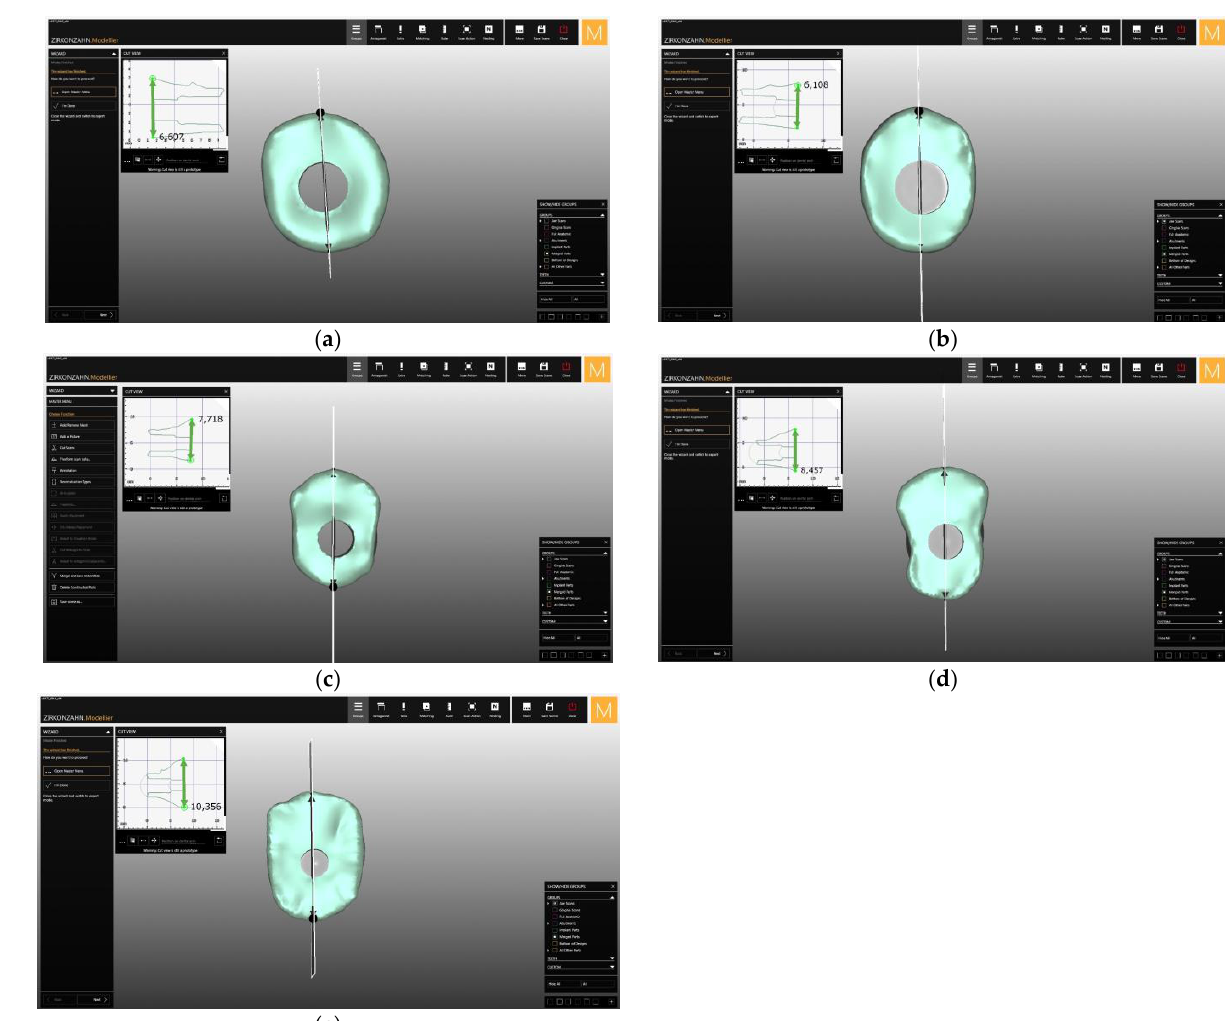
Figure 4. The laboratory design of the healing abutment for the ( a ) central incisor, ( b ) lateral incisor, ( c ) canine, ( d ) first premolar, and ( e ) first molar in the upper jaw.